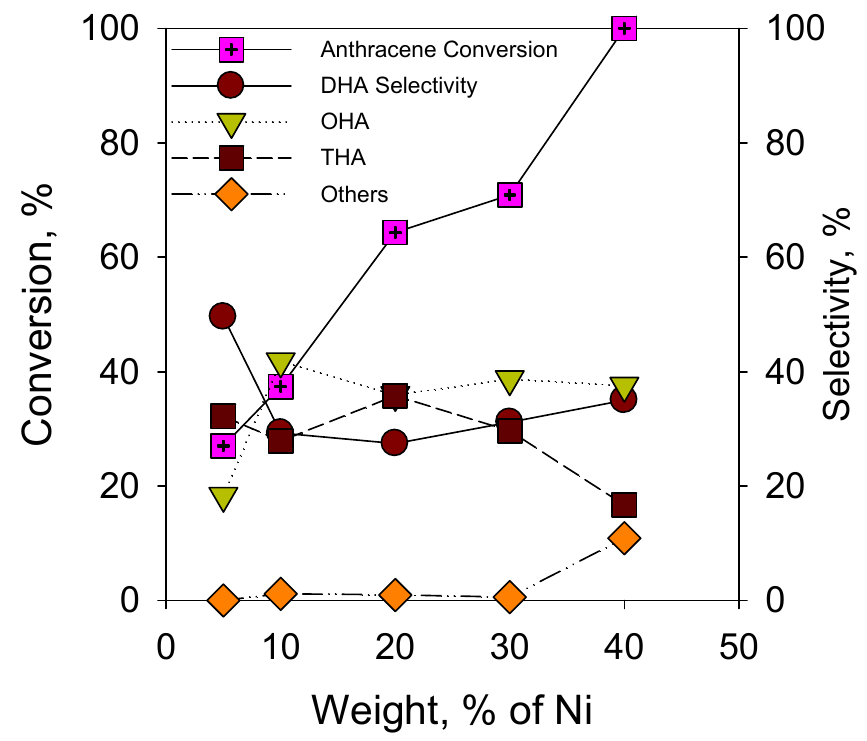
Figure 4. Effect of metal loading on hydrogenation of anthracene. Catalyst weight: 0.5 g; Reaction temperature: 100 °C; Reaction pressure: 6.9 MPa; H volume of the reactor: 50 mL; reaction time: 6